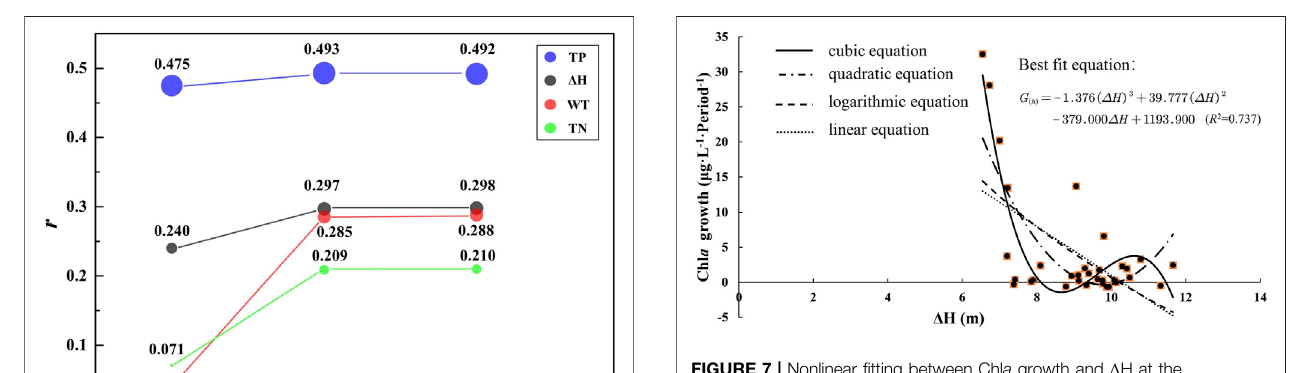
FIGURE 7 | Nonlinear fi tting between Chl a growth and Δ H at the lower